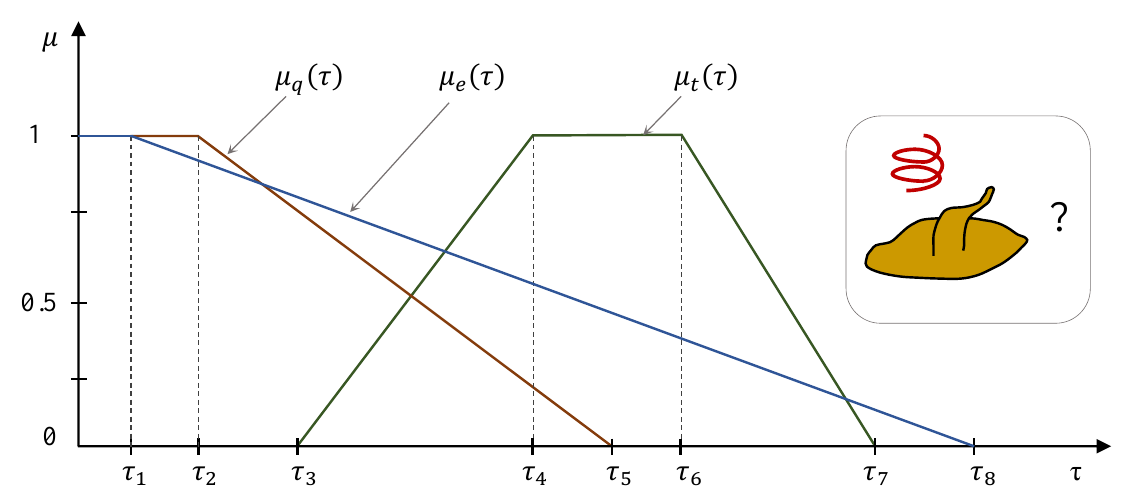
Figure 1. The problem of grilled-chicken-cooking process-optimizing. The problem is choosing the optimal cooking time based on a set of local criteria. For the mathematical formalization of local criteria, the desirability functions [27] can be used. These functions change from 0 in areas that are not allowed (undesirable) as values of the parameter of quality, up to a maximum value 1 in the areas of its most preferred values. There are no other restrictions on desirability functions other than continuity and